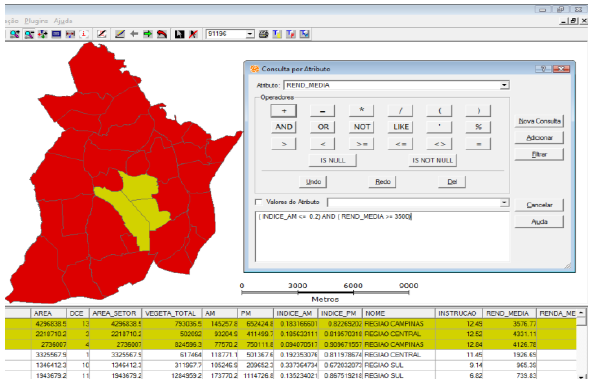
Figure 16 –Significant Changes in the Vale do Rio Meia Ponte. Conversely, we may ask what are the districts with vegetation change less than 0.2 and income higher than R$ 3.500,00 Figure 13 – Relationship between vegetation changes (LC and (Figure 17). SC) and income.